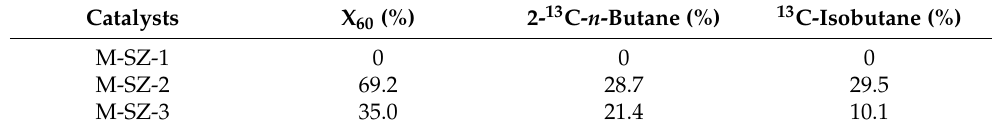
Figure 6. 13 C MAS NMR spectra of 1- 13 C- n -butane reacted at 433 K with M-SZ-2 as the catalyst at different times. Table 3. The conversion and product distribution of the butane isomerization at 433 K for 60 min. Catalysts